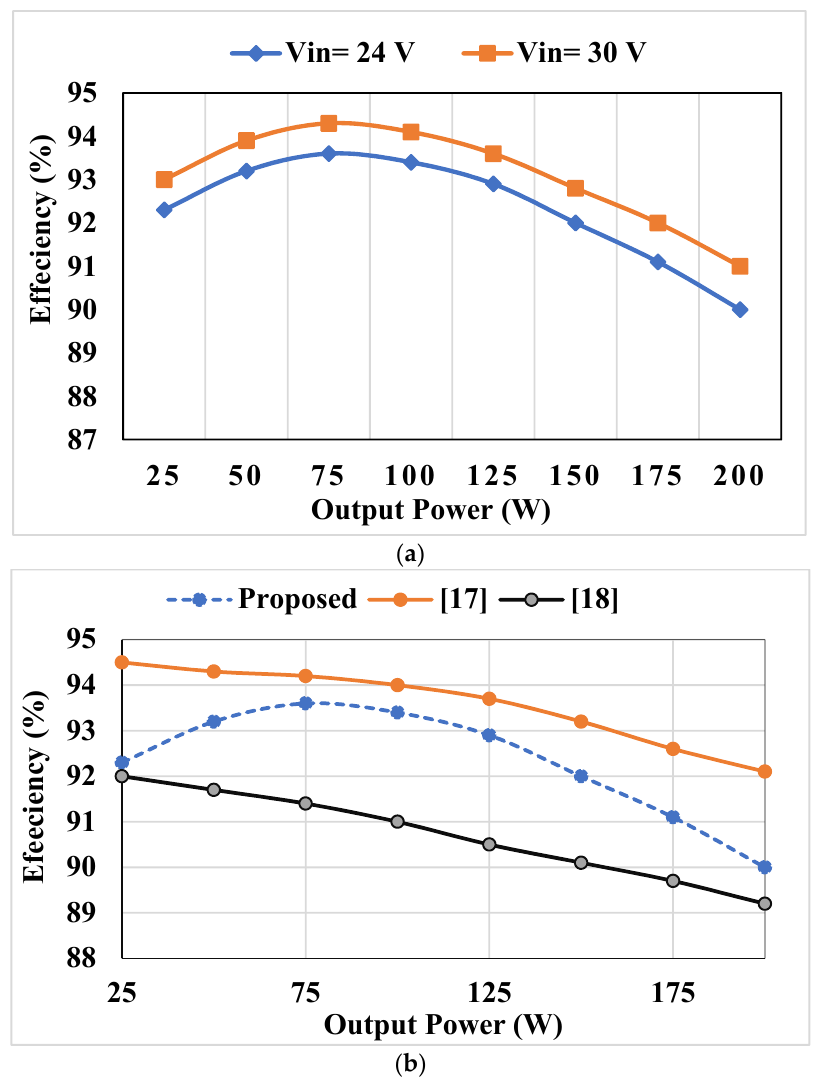
Figure 18. Bifurcation of losses in the proposed converter.